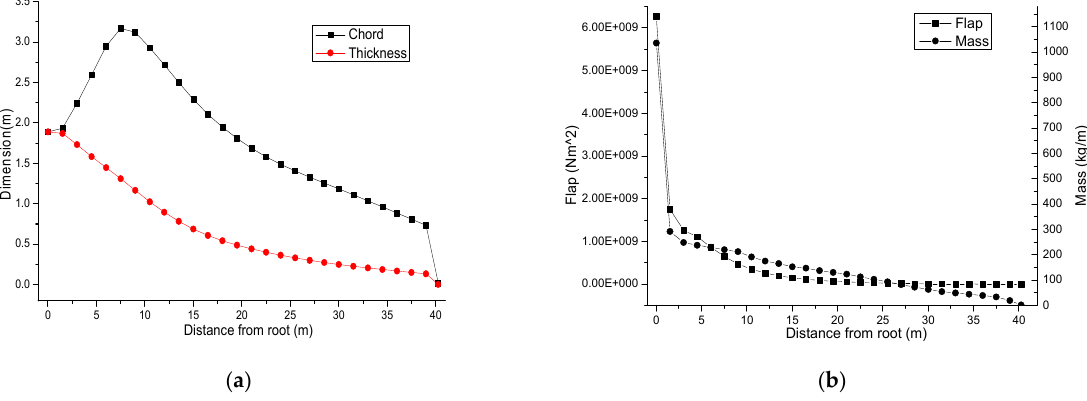
Figure 6. Al 40.3 m structure distribution along the blade length. ( a ) Chord width and thickness distribution along blade length; ( b ) Blade mass and flapwise bending stiffness distribution along the blade length.